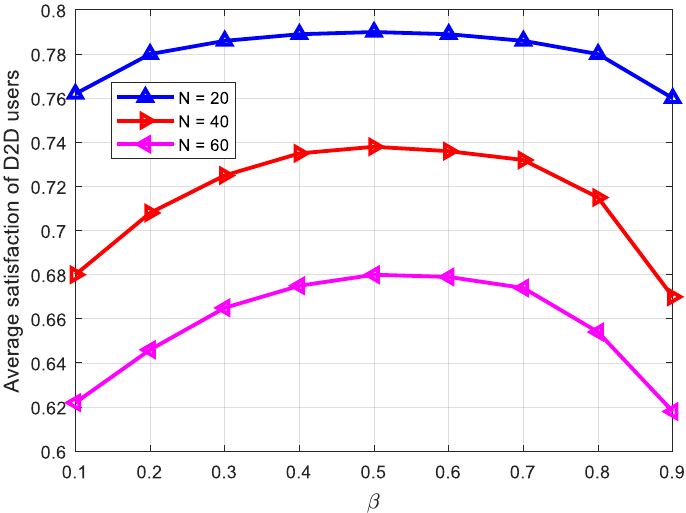
Figure 4. Comparison of the average satisfaction of D2D users under different values of 𝛽 .